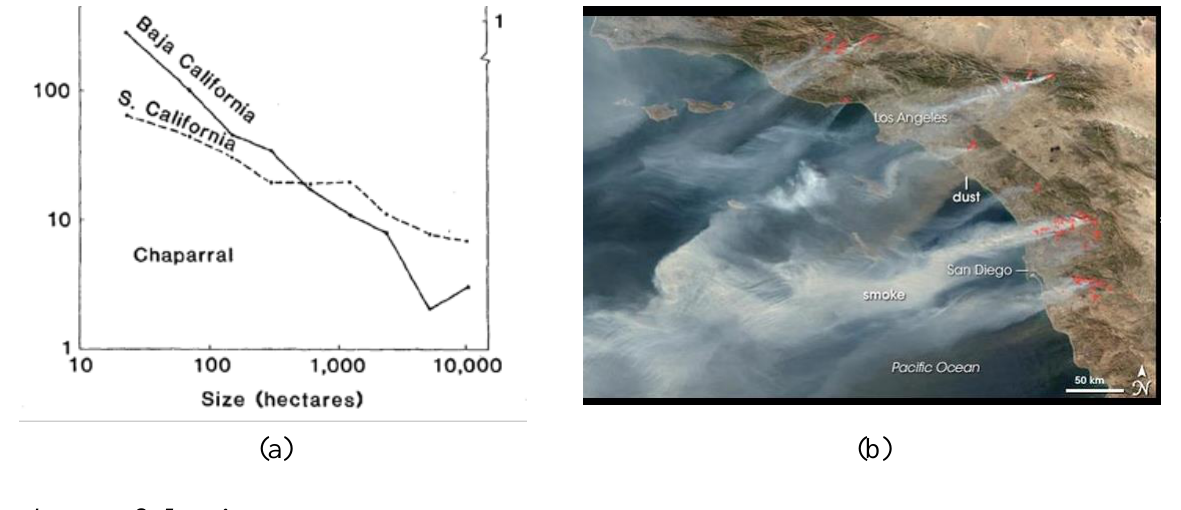
Figure 18. ( a ): Number of fires plotted against burned area for Baja California (Mexico) and Southern California (U.S.) from 1972 to 1980. Chaparral is a shrubland or heathland plant community found primarily in the U.S. state of California and in the northern portion of the Baja California peninsula, Mexico (from [31]); ( b ): Space photograph of the October 2007 California wildfires that led to 2000 km 2 of land burned from Santa Barbara County to the US-Mexico border